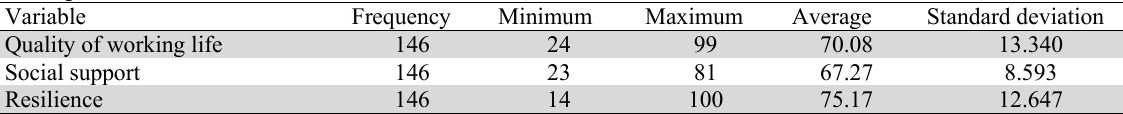
Descriptive statistics of the